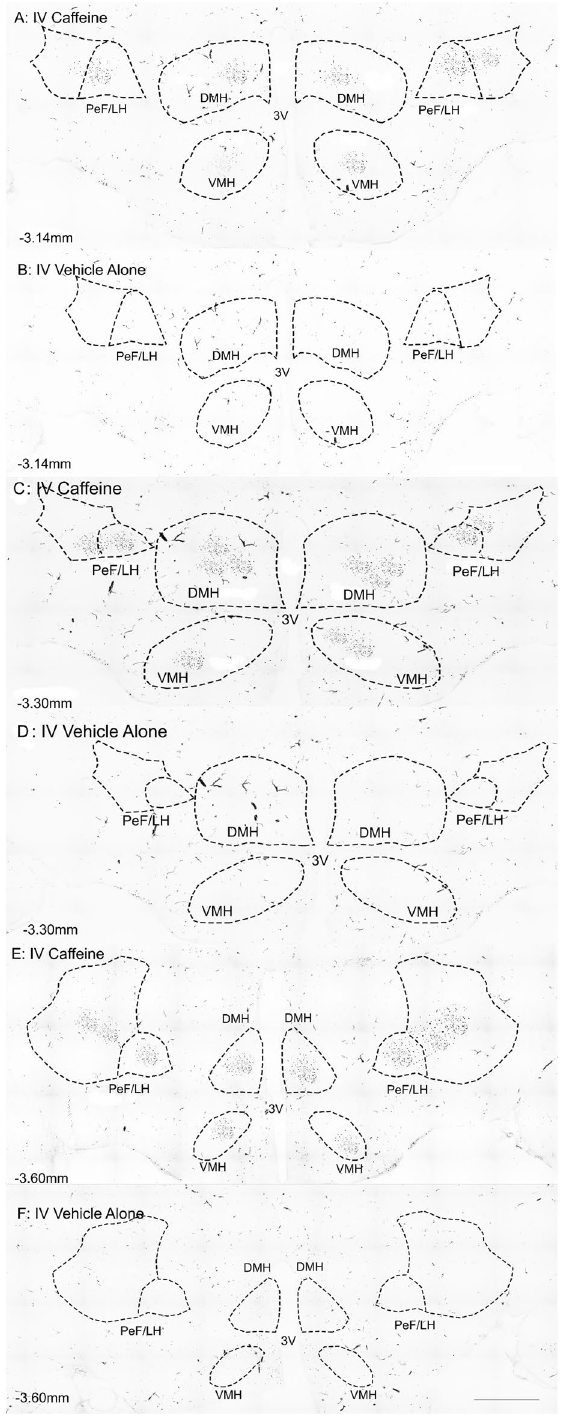
Figure 5. Photomicrographs illustrating the rostrocaudal levels of caffeine treated rats. Areas include the dorsomedial hypothalamus (DMH, ventromedial hypothalamus (VMH), and peri-fornical area of the lateral hypothalamus (PeF/LH) selected for analysis, and delineation of regions by immunostaining of c-Fos ir (dark speckled puncta on image): ( A ) represents − 3.14 mm bregma of caffeine treated rats; ( B ) represents − 3.14 mm bregma of vehicle treated rats; ( C ) represents − 3.30 mm bregma of caffeine treated rats; ( D ) represents − 3.30 mm bregma of vehicle treated rats; ( E ) represents − 3.60 mm bregma of caffeine treated rats; ( F ) represents − 3.60 mm bregma of vehicle. Dashed lines represent regions of interest. 3 V 3rd ventricle. Scale bar, 200